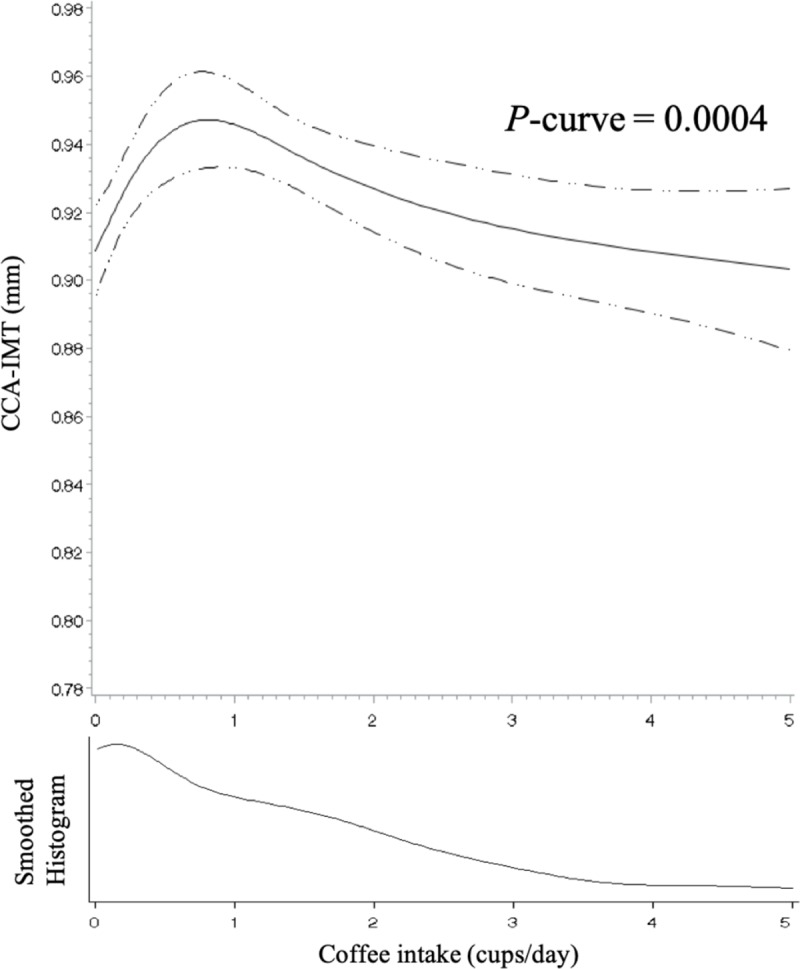
Association between coffee intake and common carotid artery intima-media thickness among 1,235 participants of the Study of Women’s Health Across the Nation (United States) using restricted cubic splines, 1996–2013.The solid line represents the predicted least squares means computed using sample means for continuous covariates and sample percentages for categorical covariates. The dashed lines represent the 95% confidence limits. Four knots were placed at 5th, 35th, 65th, and 95th percentiles of the sample distribution corresponding to 0, 0.29, 1.40, and 4.35 cups/d, respectively. One serving of coffee was defined as one medium cup (237 mL). P-curve was computed using the likelihood ratio test comparing the model with only the linear term to the model with the linear and the cubic spline terms. The model was adjusted for age at the carotid scan, race/ethnicity, education level, financial strain, self-rated overall health, BMI, smoking status, non-occupational physical activity level, menopausal status, use of hormone therapy from baseline to the visit of the carotid scan, the number of missing visits for dietary measurements, total energy intake, Alternate Healthy Eating Index, intake of tea, intake of alcoholic beverages, intake of beverage condiments, elevated blood pressure, elevated fasting glucose, elevated triglycerides, and reduced HDL cholesterol. Extreme coffee intake (> 5 cups/d) was trimmed from the graph due to sparse data. Abbreviations: CCA, common carotid artery; IMT, intima-media thickness.